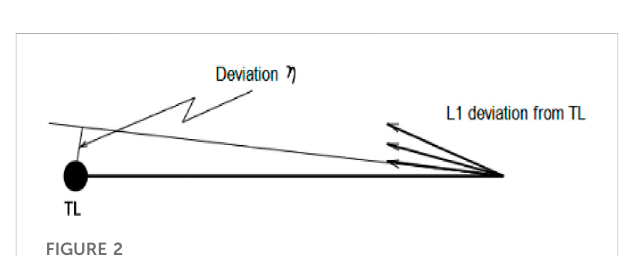
FIGURE 2 Geometric description of the deviation parameter η